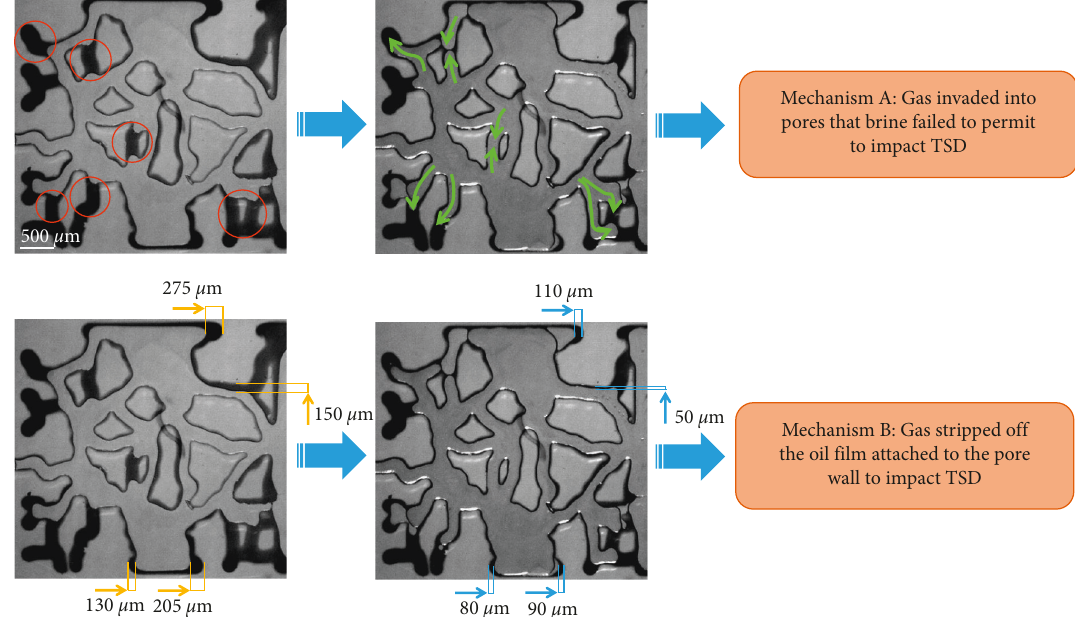
Figure 7: The mechanism of TSD by gas flooding based on microfluidic visualization experiment.